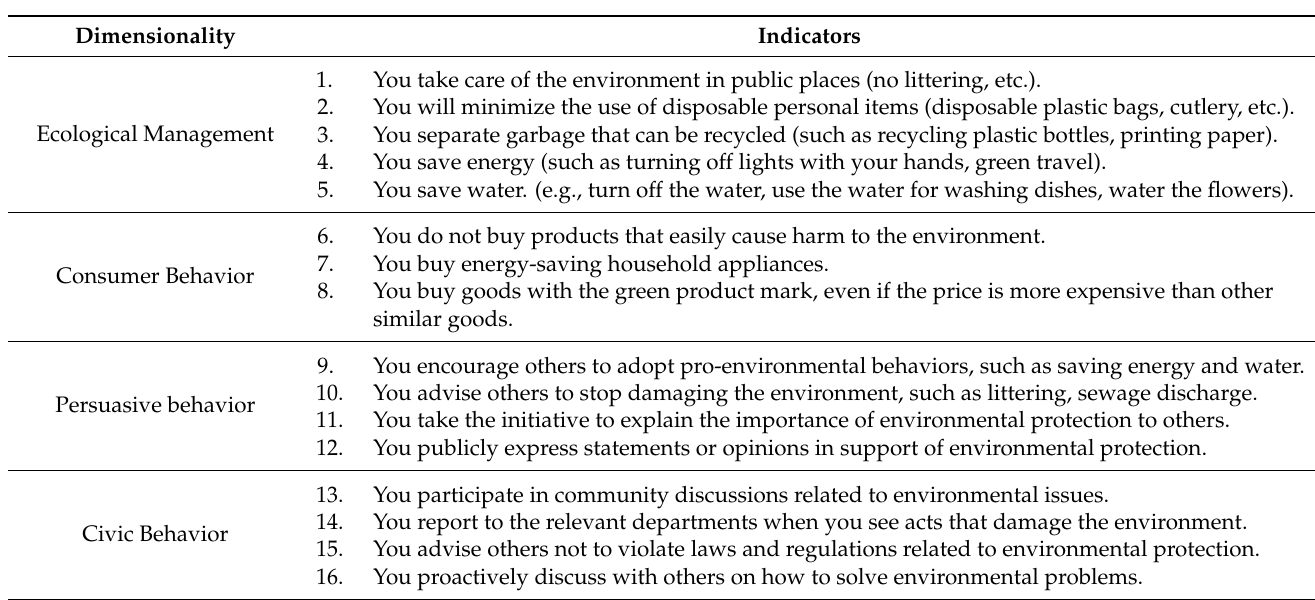
Table 4. Pro-environmental behavior evaluation